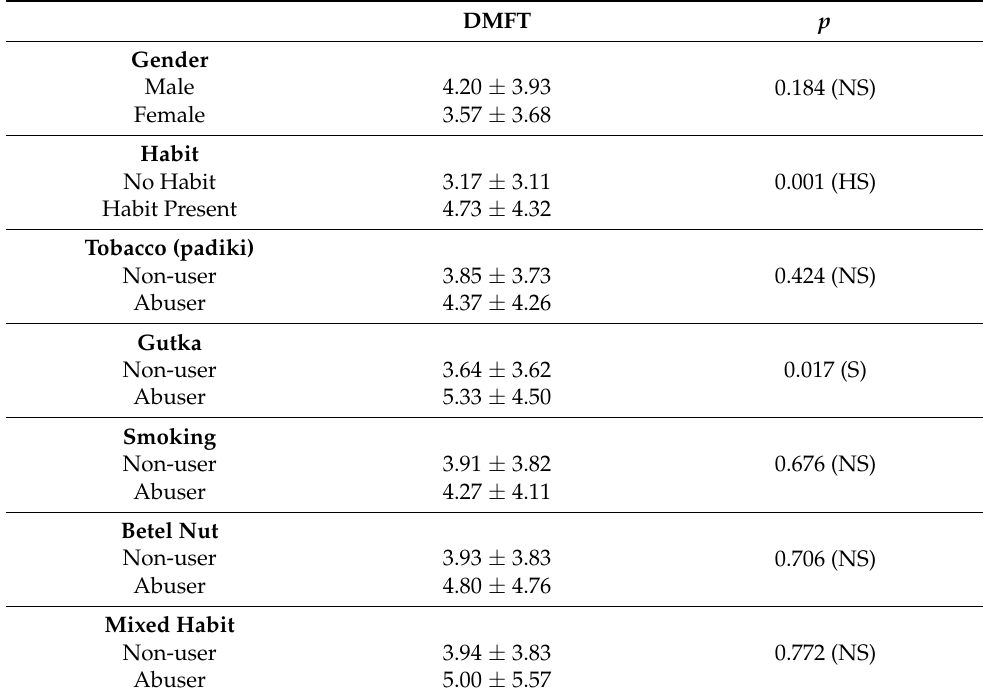
Table 4. Dental caries distribution among varying tobacco substance